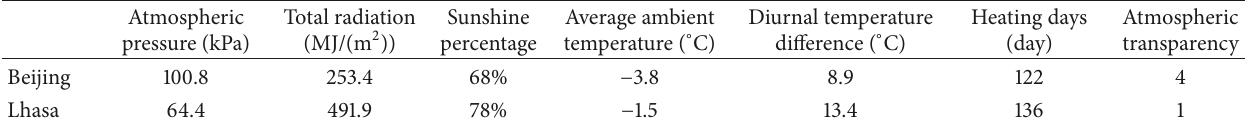
Table 1: Climatic characteristics of Beijing and Lhasa in